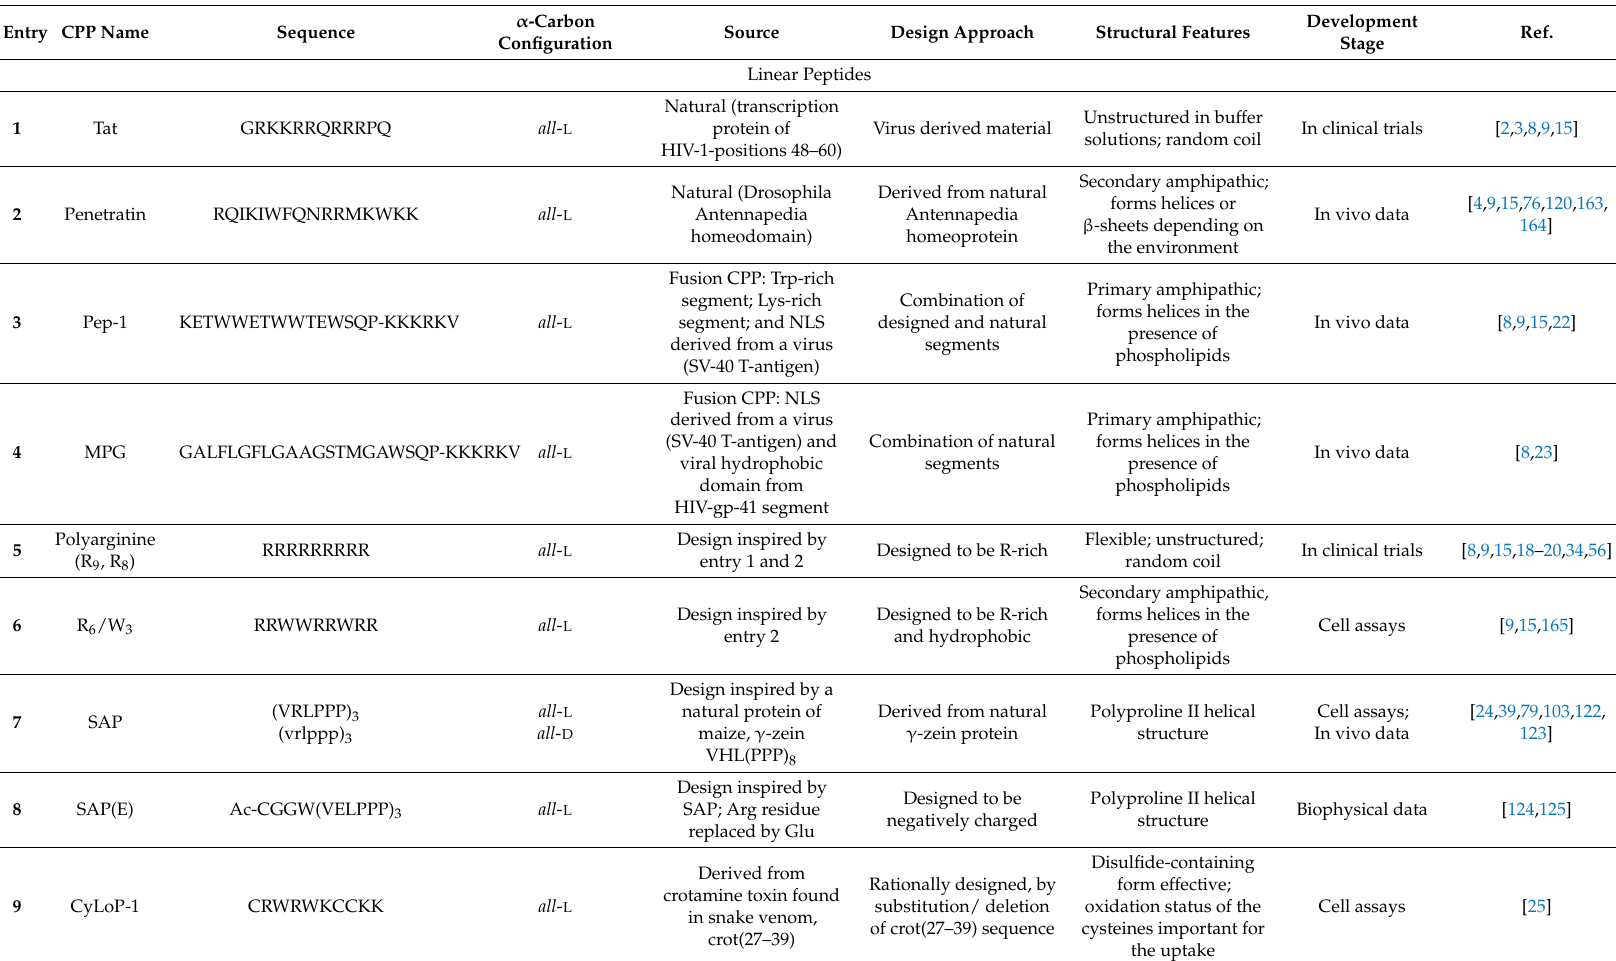
Table 1. Examples of CPPs and their sequences, α -carbon stereochemistry, source, design strategy, structural features and development